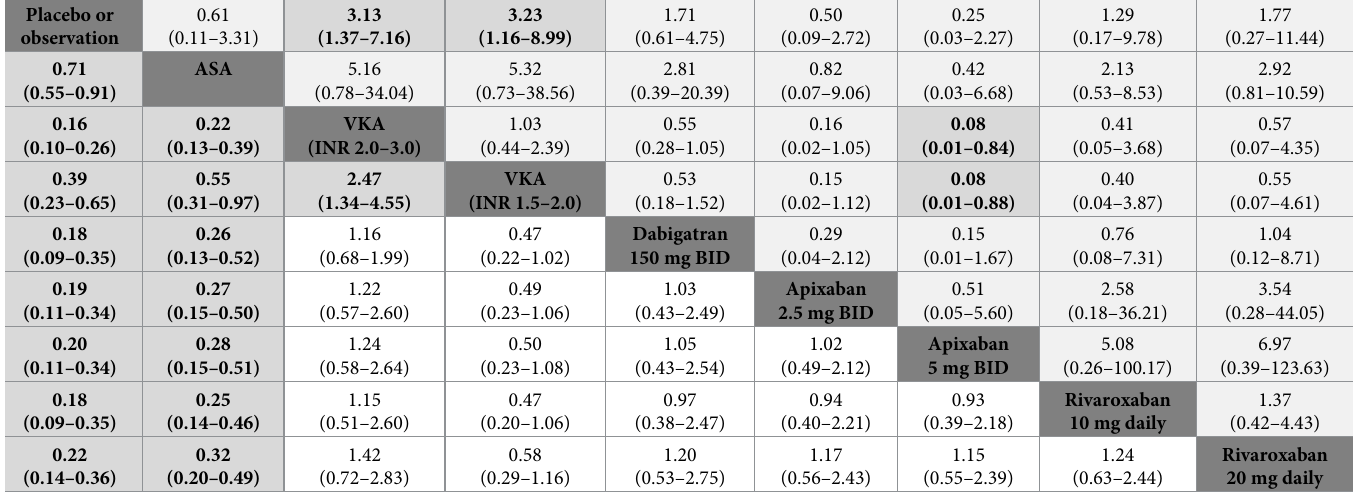
Table 2. Relative risk (95% confidence interval) from network meta-analysis for recurrent thromboembolism events and major bleeding for all pairwise comparisons. Placebo or observation